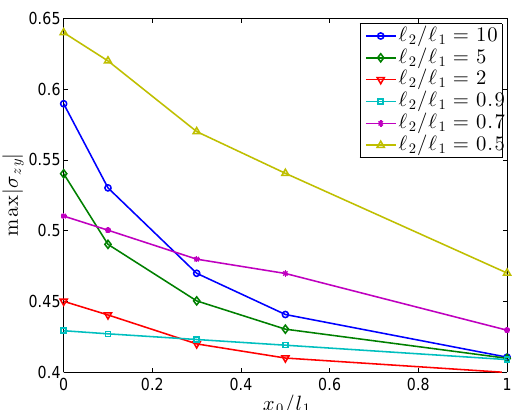
Figure 5: Dependence of max | σ zy | on the normalized dislocation position x / l for µ and different values of l . The stress 1 2 / l 1 1 = µ 2 values are given in units of µ . 1 b /(2 πl 1 )